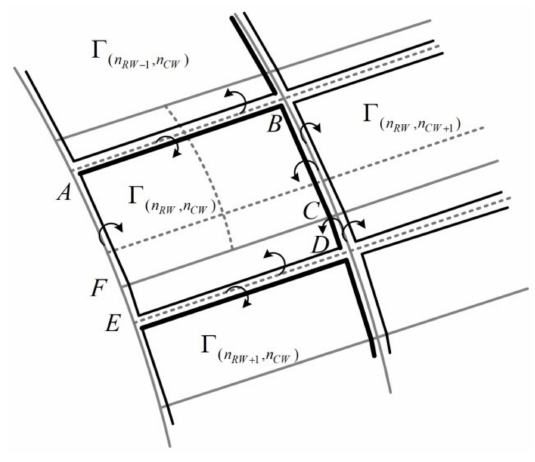
Figure 5. Neighboring rings for a general vortex